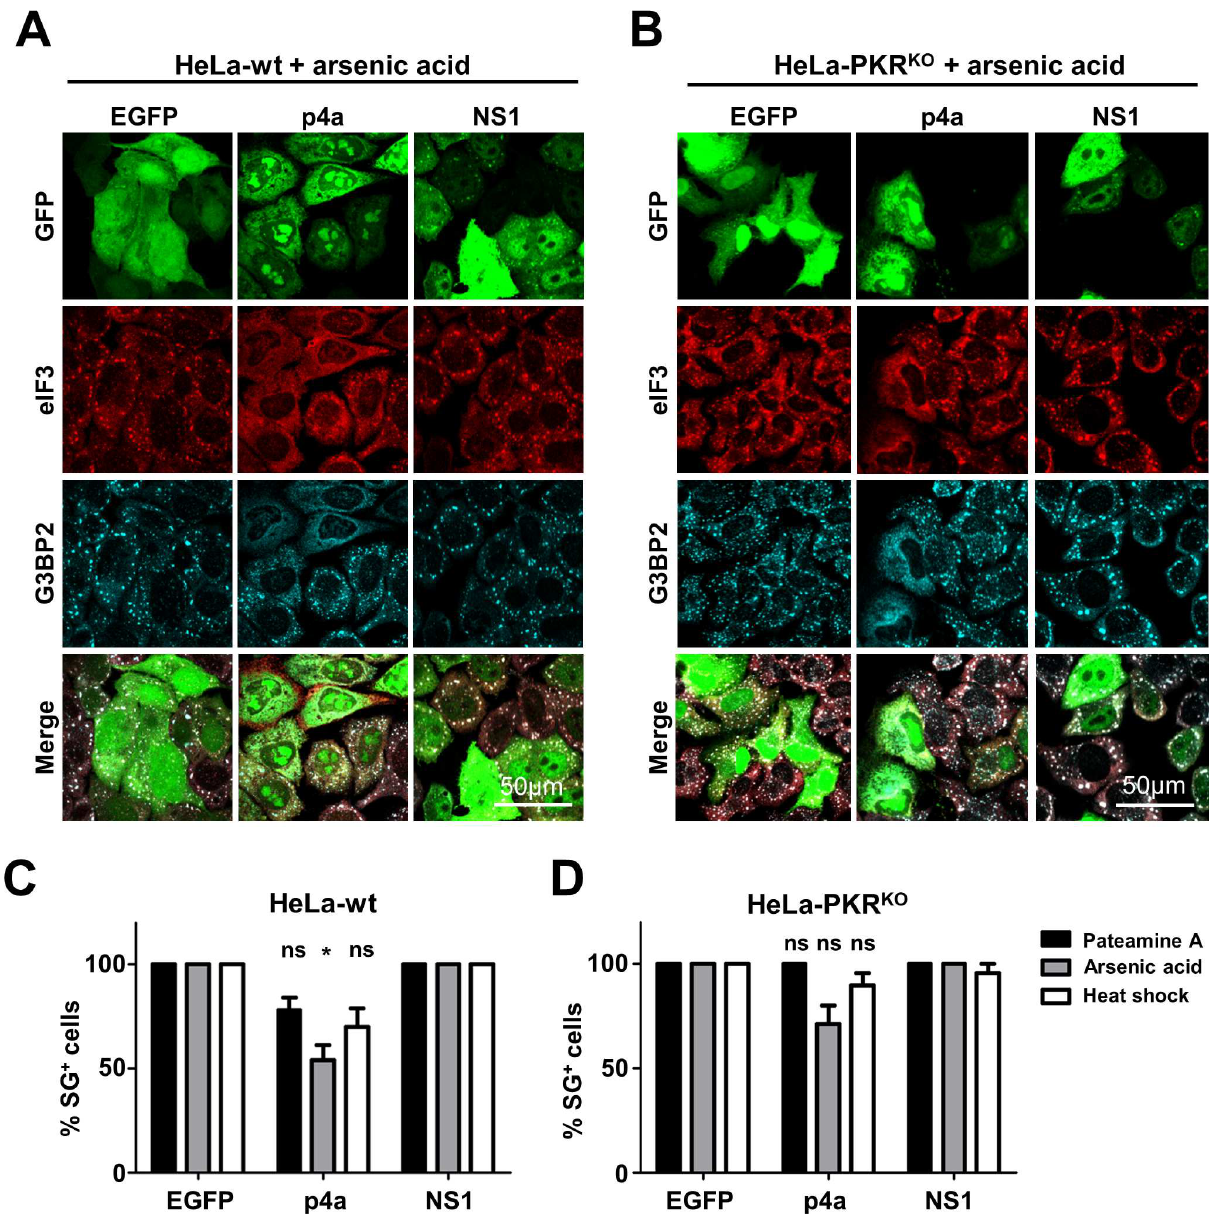
Fig 4. MERS-CoV p4a does not inhibit PKR-independent SG formation. (A, B) Immune fluorescence images of HeLa-wt cells (A) and HeLa-PKR KO cells (B) transfected with the indicatedpEGFP-expression plasmids. Next day, SG formation was triggered using arsenic acid (0.5 mM for 30 min). Cells were fixed and stained for eIF3 (shown in red) or G3BP2 (shown in cyan). EGFP expressionis shown in green. (C, D) Quantification of SG-positive HeLa-wt cells (C) and HeLa-PKR KO cells (D) treated with Pateamine A (100 nM for 2h), arsenic acid (0.5 mM for 30 min), or heat shock (50˚C for 30 min). SG-positive cells were quantifiedfrom three randomly selected images. Shown are means with standard deviations, which were analyzedusing an unpairedt-test. ( * , p < 0.05; ns, not